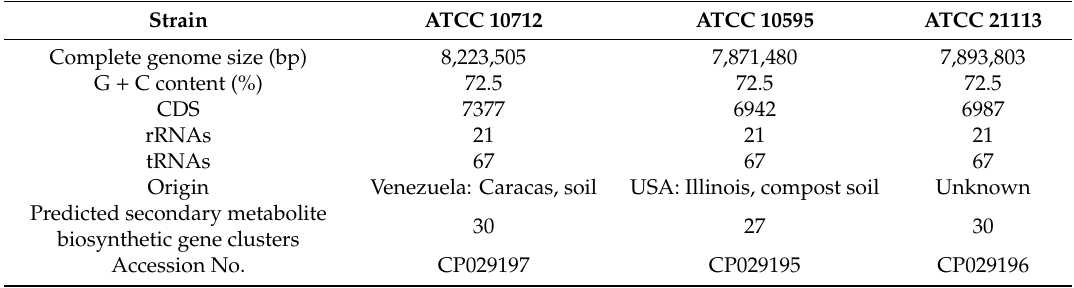
Table 1. Characteristics of the complete genomes of S. venezuelae